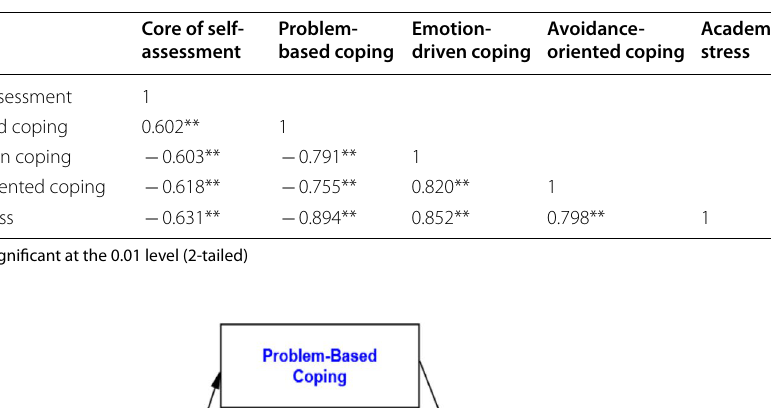
Table 4 Examining the correlation between research variables